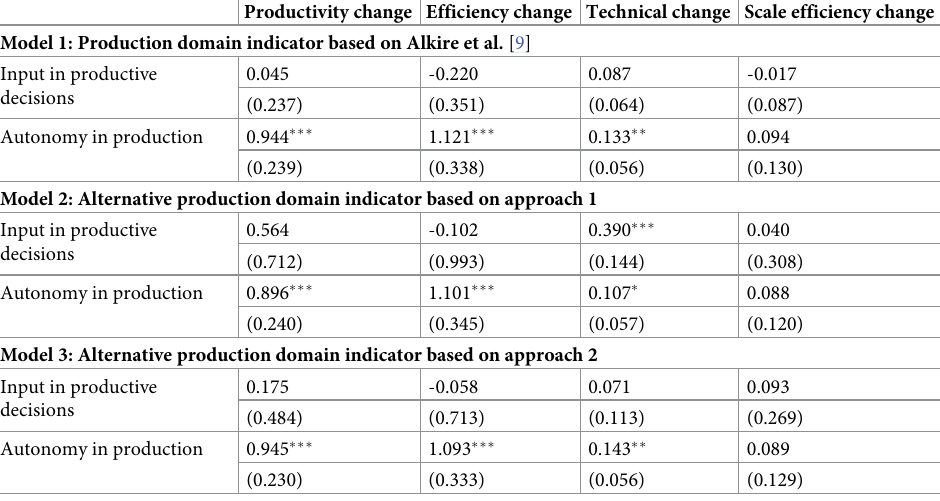
Table 9. Results of the OLS bootstrap regression of the determinants of farm productivity change and its compo- nents (production domain indicators). Productivity change Efficiency change Technical change Scale efficiency change Model 1: Production domain indicator based on Alkire et al. [9]